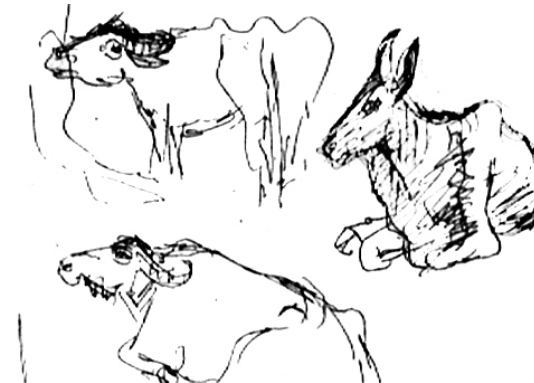
fig. 9. le Corbusier’s sketch of Pinjore Gardens, India (Spectrum 2014)